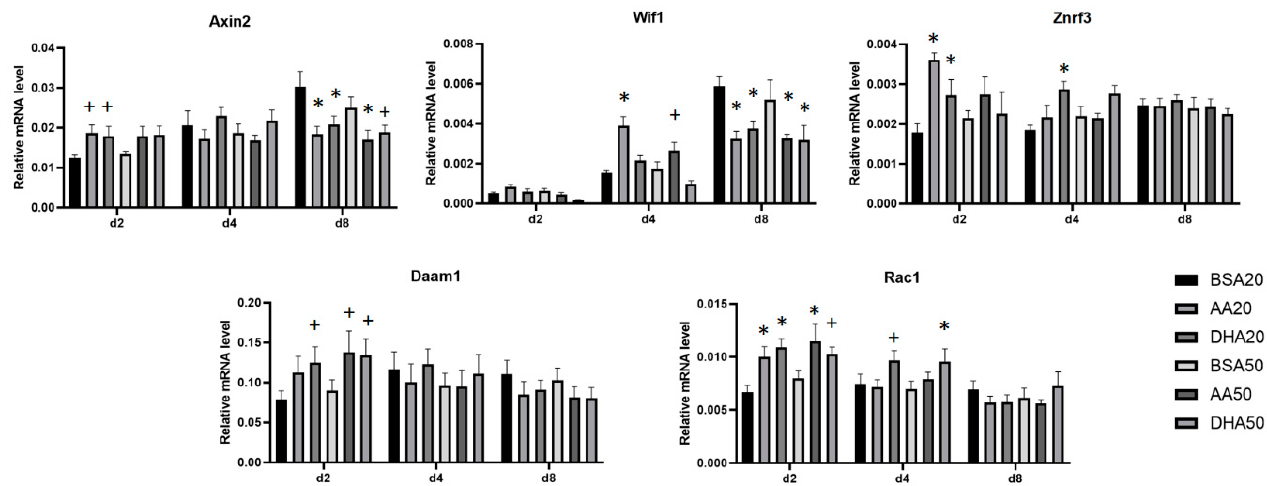
Figure 7. The mRNA levels of negative regulators of Wnt signaling pathway at three time points, i.e., 2 days treatment (d2), day 4 (d4; 2 days treatment + 2 days recovery) and day 8 (d8; 2 days treatment + 6 days recovery). The mRNA levels of Axin and Znrf3 were increased at d2 relatively on all treated cells. The mRNA levels of Wif1 and Axin2 were decreased in all treated cells at day 8. All values are LS means ± SEM, + indicate p < 0.1 and * indicate p < 0.05 treatment vs. respective BSA control group.